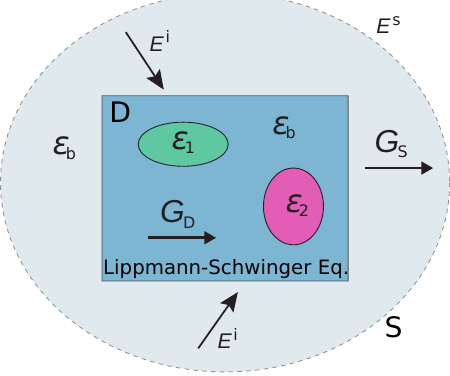
Figure 1. Schematics of inverse scattering